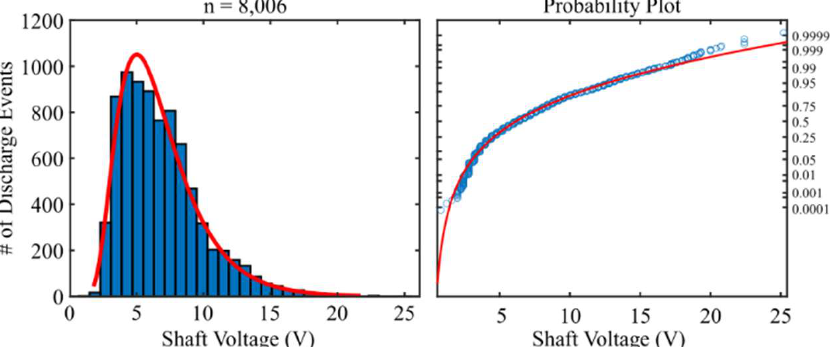
Figure 19. Histogram with inverse Gaussian distribution and probability plot for SiC inverter shaft breakdown voltage data at a bearing temperature of 45 °C. In 1000 ms at f s = 10 kHz, 8006 discharge events were recorded. Table 4. Summary of mean ( µ ) and shape ( λ ) parameters for shaft discharge voltage inverse Gaussian distributions over various bearing operational